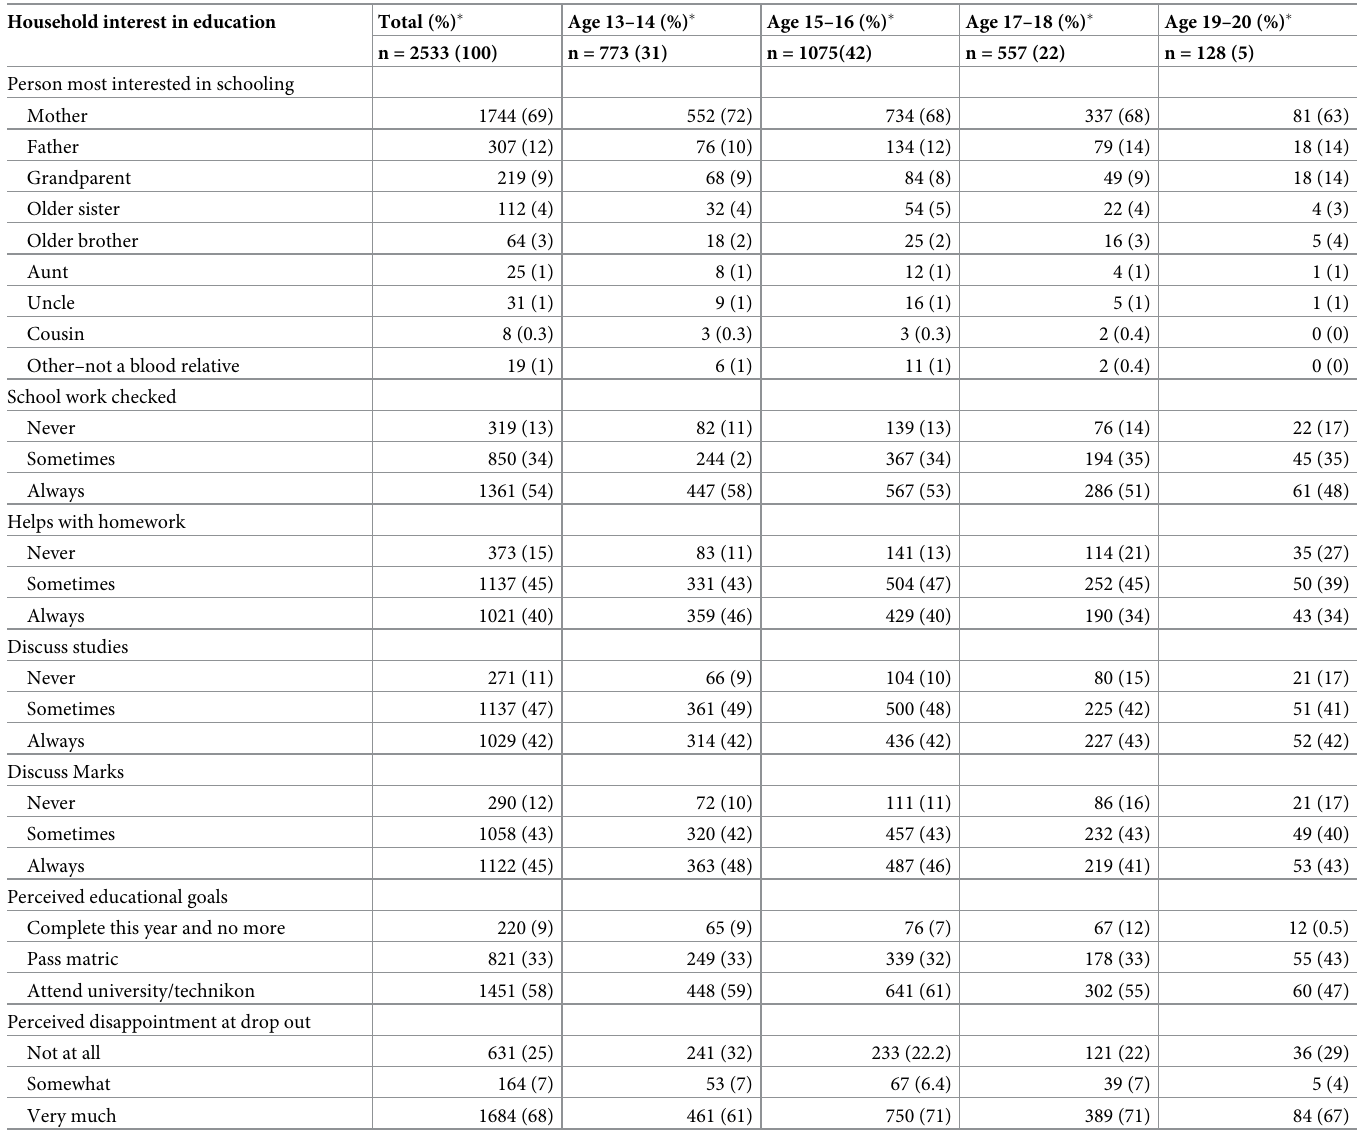
Table 4. Household interest in education, overall and by age